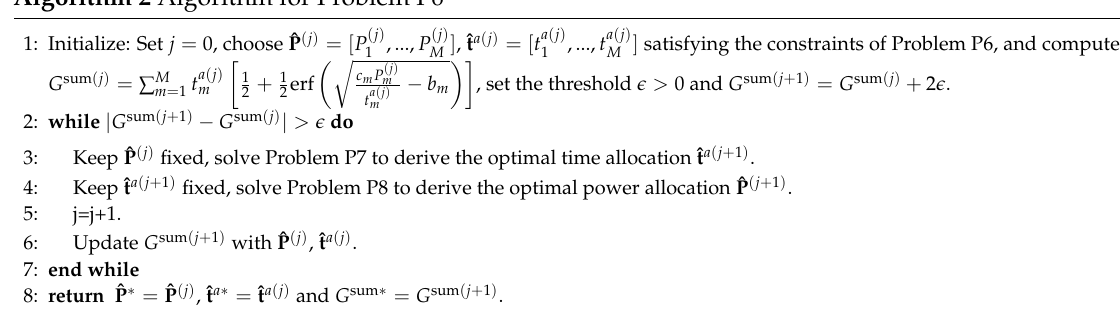
Algorithm 2 Algorithm for Problem